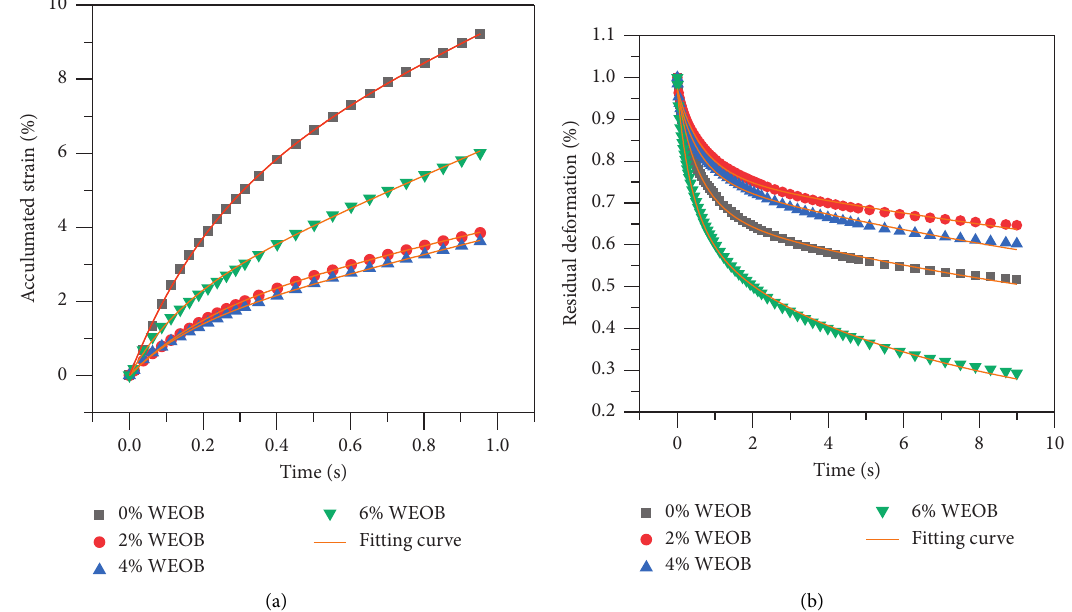
Figure 9: Comparison of measured and predicted values of SBS asphalt with different WEOB content in Burgers Table 5: Regression analysis of creep for SBS modifier asphalt with different WEOB content in Burgers model. Regression equation and parameters of Burgers model Ratio